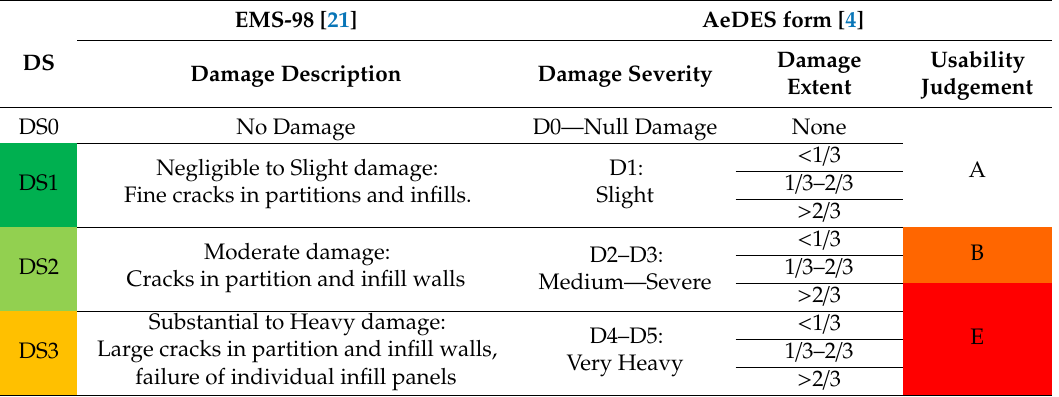
Table 5. Assumed correspondence between usability judgments and damage levels according to EMS-98 and AeDES form (background colors are used in the figures to tag each DS or usability